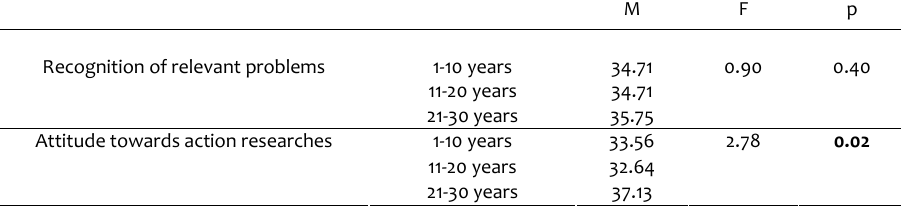
Table 4 : Teachers’ competences and attitudes towards conducting action researches considering their teaching experience